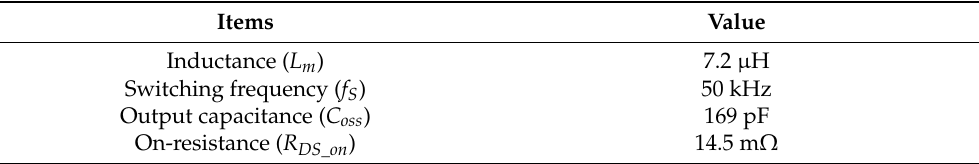
Table 2. Simulation parameters of the proposed equalizer.